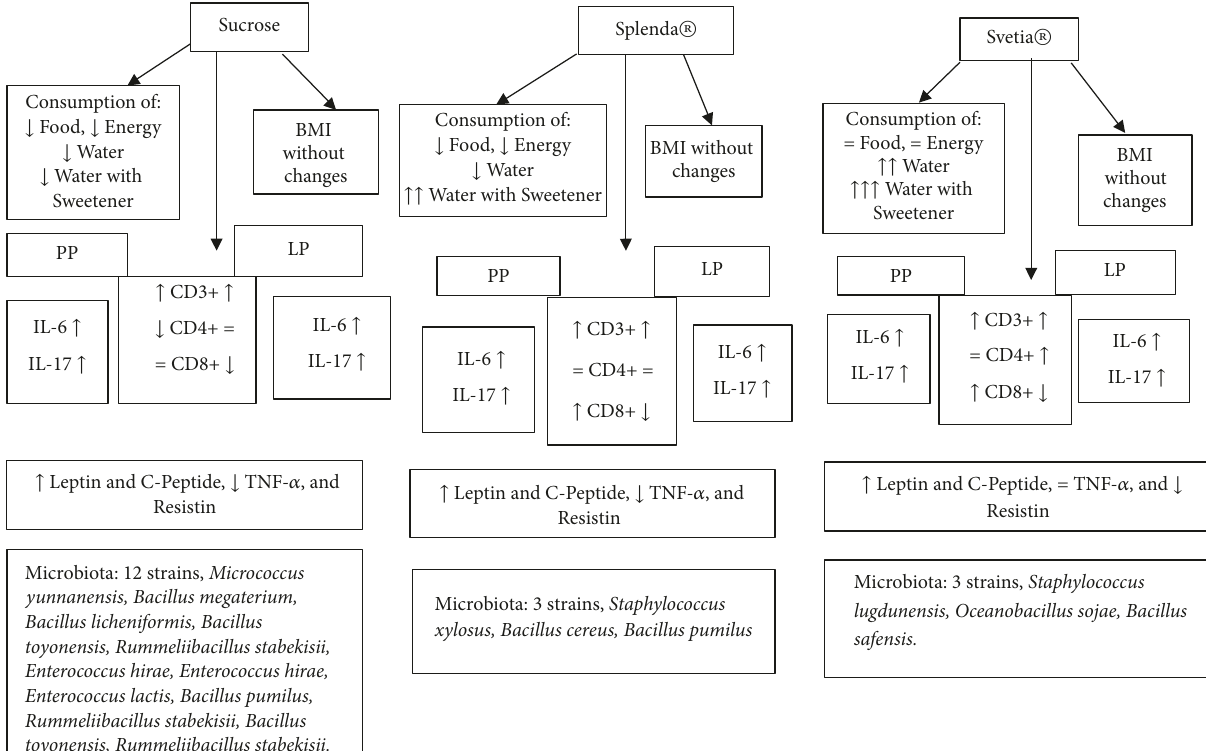
Figure 3: Representing the integration of quantified parameters after 12 weeks of supplementation with sweeteners. Peyer patches (PP), lamina propria (LP), interleukin-6 (IL-6), interleukin-17 (IL-17), and Cluster of Differentiation 3, 4, 8 (CD3+, CD4+, and